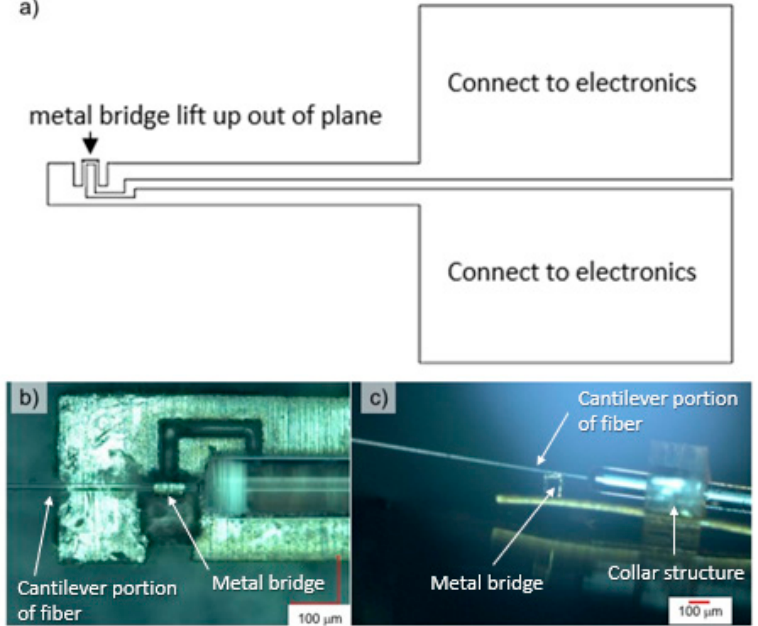
Figure 3. Assembly process of the main components of thermal actuator: ( a ) schematic showing the pattern cut out of the metal thin foil to create the metal actuator bridge; ( b ) top view of the optical fiber resting on the metal actuator; ( c ) side view of the assembled system, with a collar structure to fix components in place.